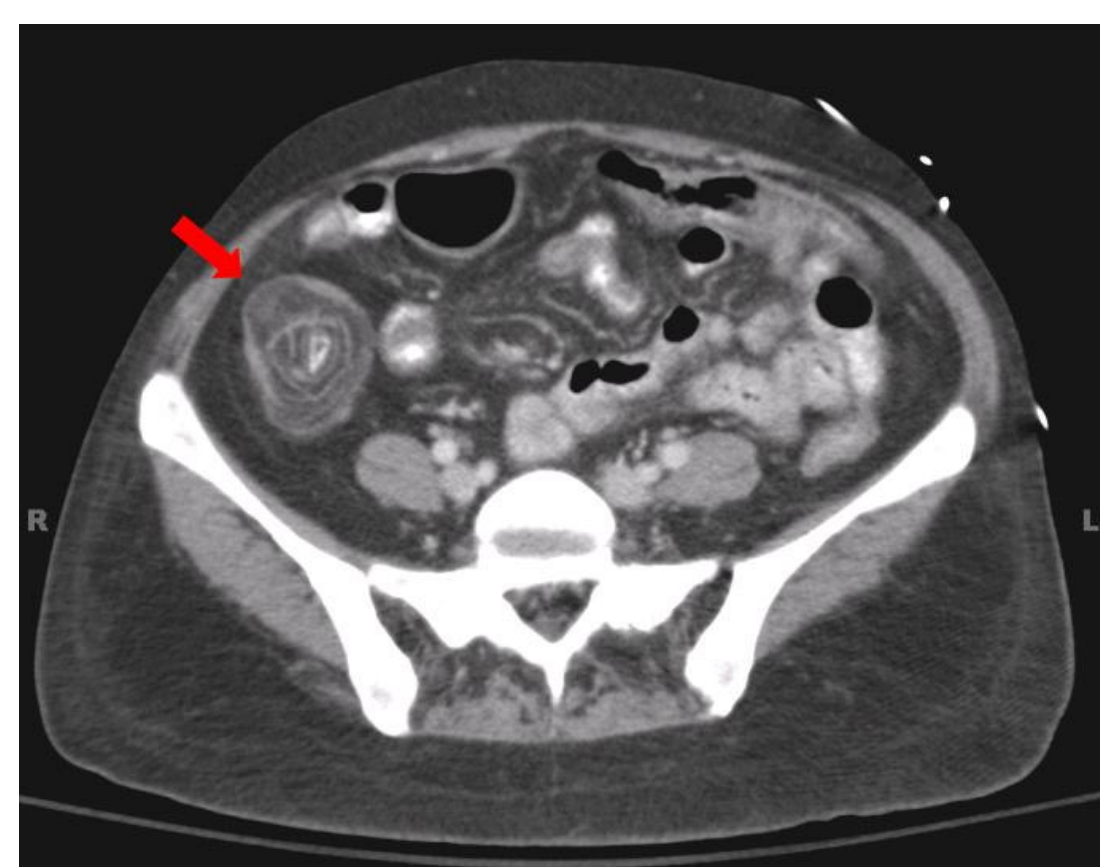
FIGURE . CT of the abdomen with target sign, suggesting ileocolic intussusception (see